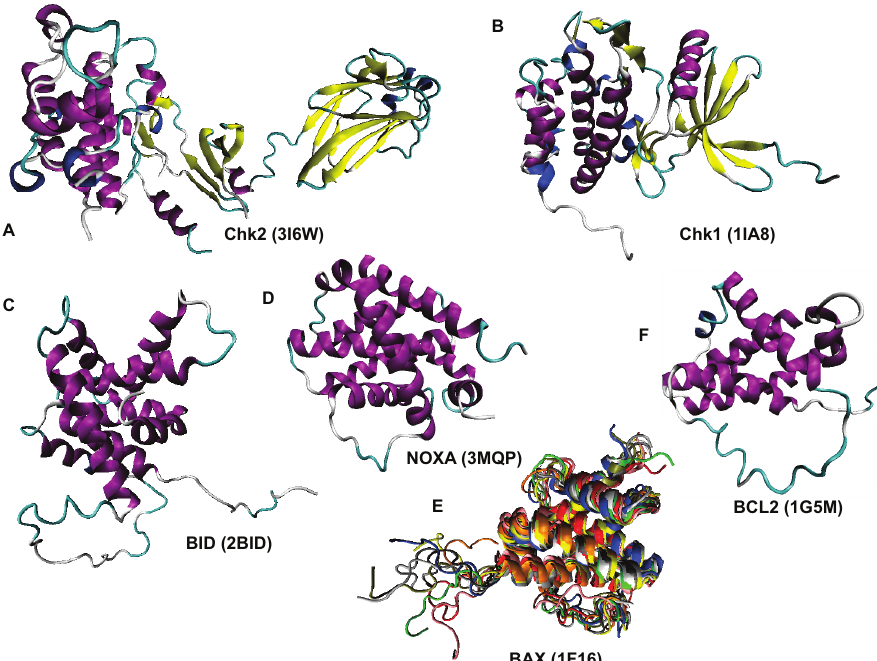
Figure 12. Structural characterization of human proteins involved in the p53-mediated apoptotic signaling pathways: group II. A . CHK2 (PDB ID: 3I6W); B . CHK1 (PDB ID: 1IA8); C . BID (PDB ID: 2BID); D . NOXA (PDB ID: 3MPQ); E . BAX (PDB ID: 1F16); F . BCL-2 (PDB ID: 1GM5).